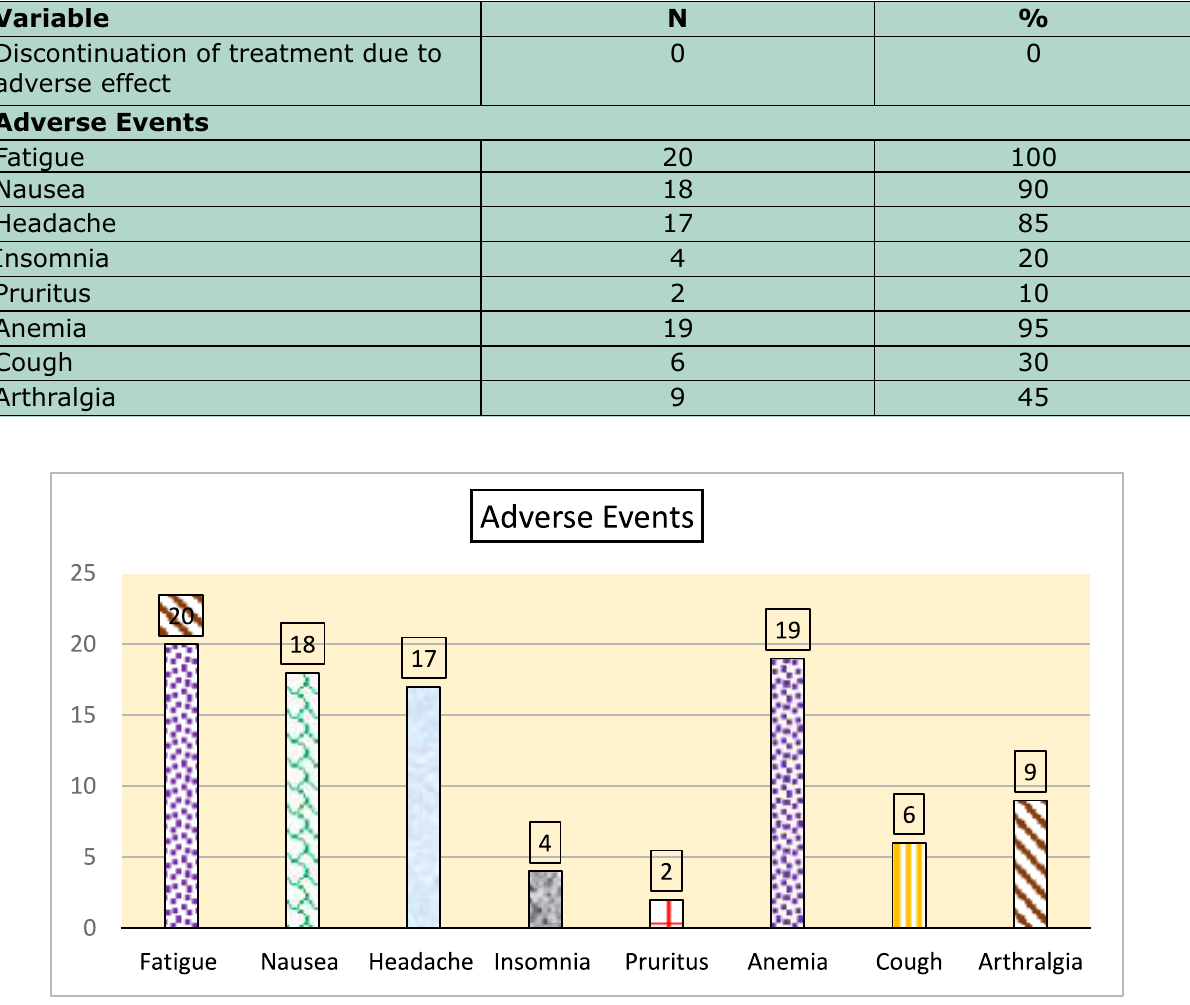
Figure-I: Adverse events after drug use